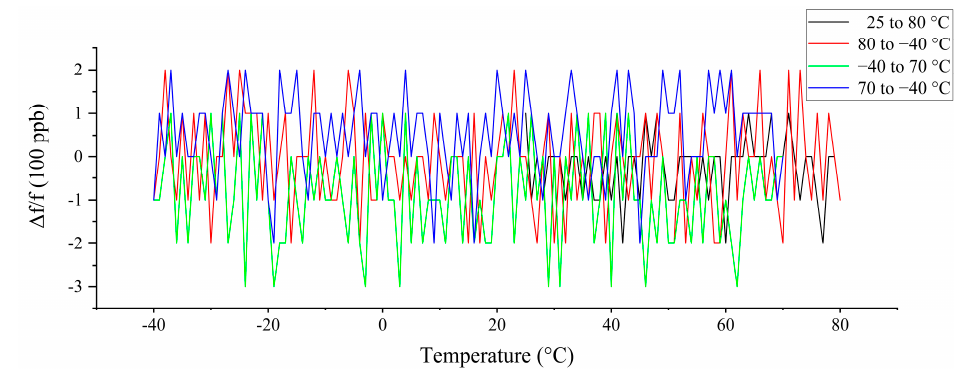
Figure 12. Frequency–temperature curve after thermal hysteresis compensation ( − 40 to 80 °C).